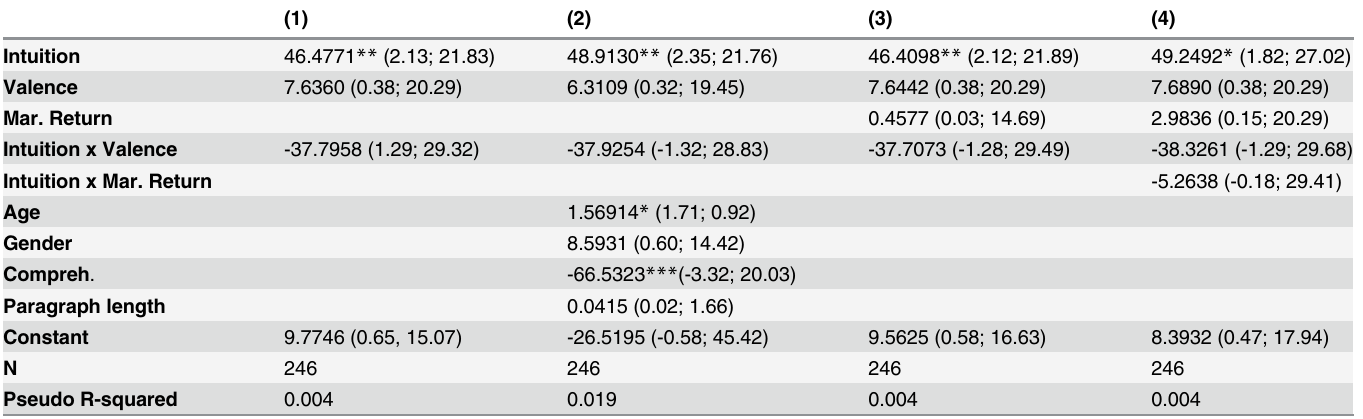
Table 2. Results from Tobit